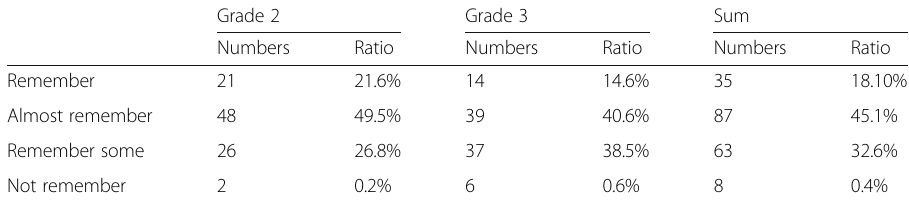
Table 2 Lexical source analysis